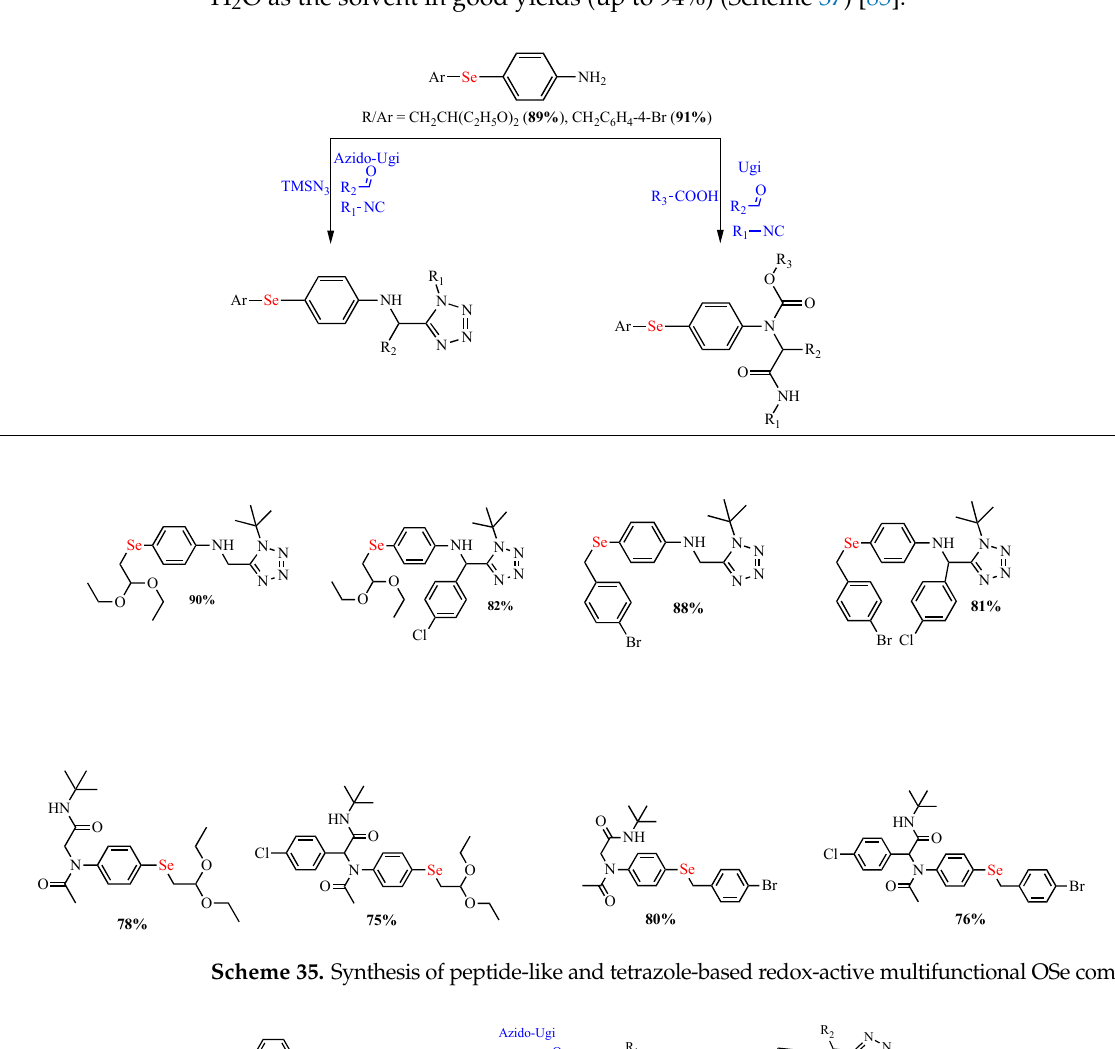
3-isocyanopropyl(phenyl)selane. The reaction was achieved under mild conditions using H 2 O as the solvent in good yields (up to 94%) (Scheme 37) [85].